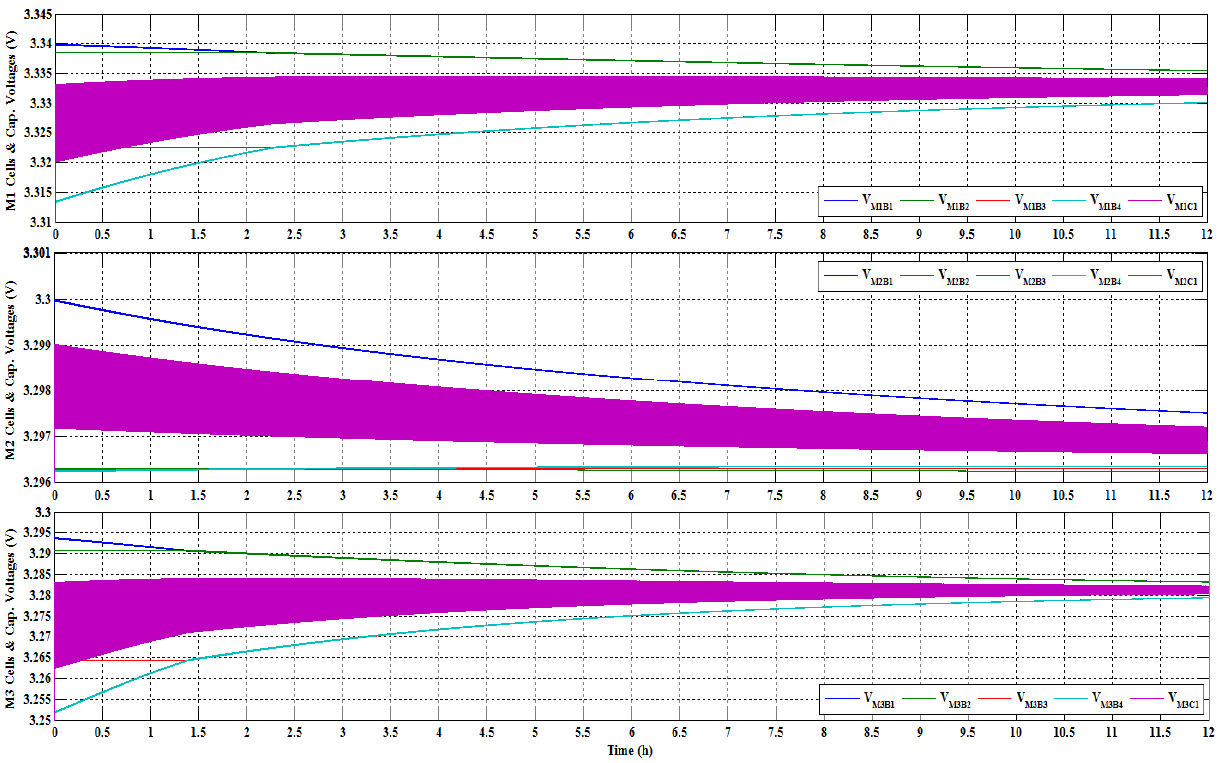
Figure 8. Simulation No. 1 (SSCs only) results: Module 1 cells voltages, Module 2 cells voltages and Module 3 cells voltages (including the capacitor voltage).